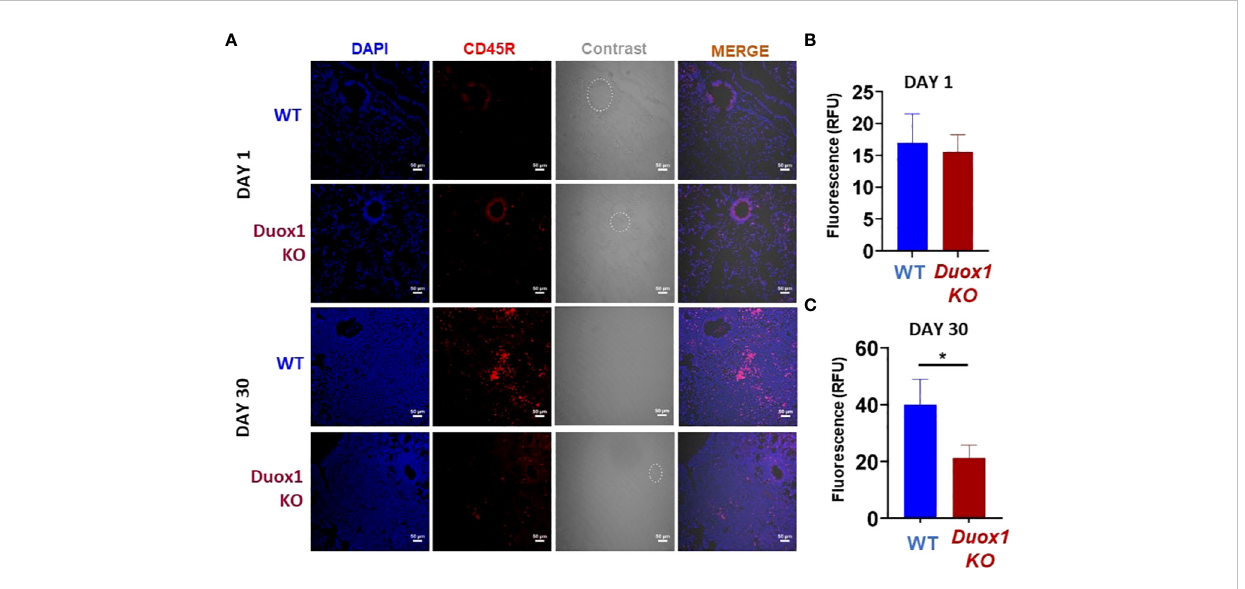
FIGURE 7 Duox1-depndent B cell accumulation in Mtb -infected lungs. Duox1 KO and WT mice were aerogenically infected with Mtb Erdman (200 CFU). Lung tissues were obtained at 1 and 30 day(s) post-infection, fi xed and immuno fl uorescence staining was performed using anti-mouse CD45R speci fi c for B cells (red). DAPI (blue) was used to depict cellular DNA. (A) Representative images of fi ve similar results (n = 5 WT and n = 5 Duox1 KO mice) are shown. Quantitation of CD45R fl uorescence at (B) 1 day post-infection and (C) 30 days post-infection. Scale bars indicate 50 m m. Mean fl uorescent